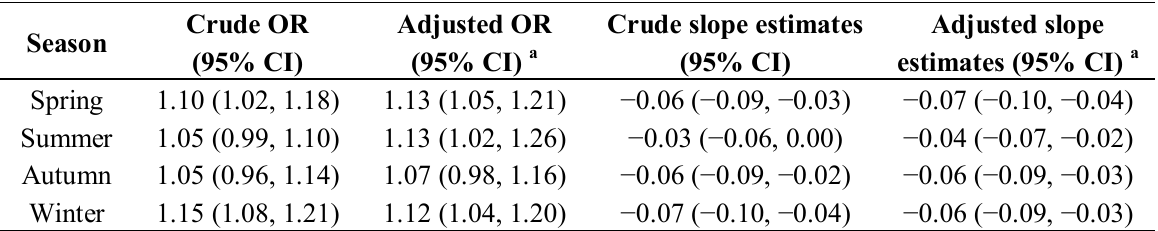
Table 6. Season- specific ORs for preterm delivery and β -coefficients for gestational period (in weeks) per 10 µg/m 3 increase in 1st trimester O 3